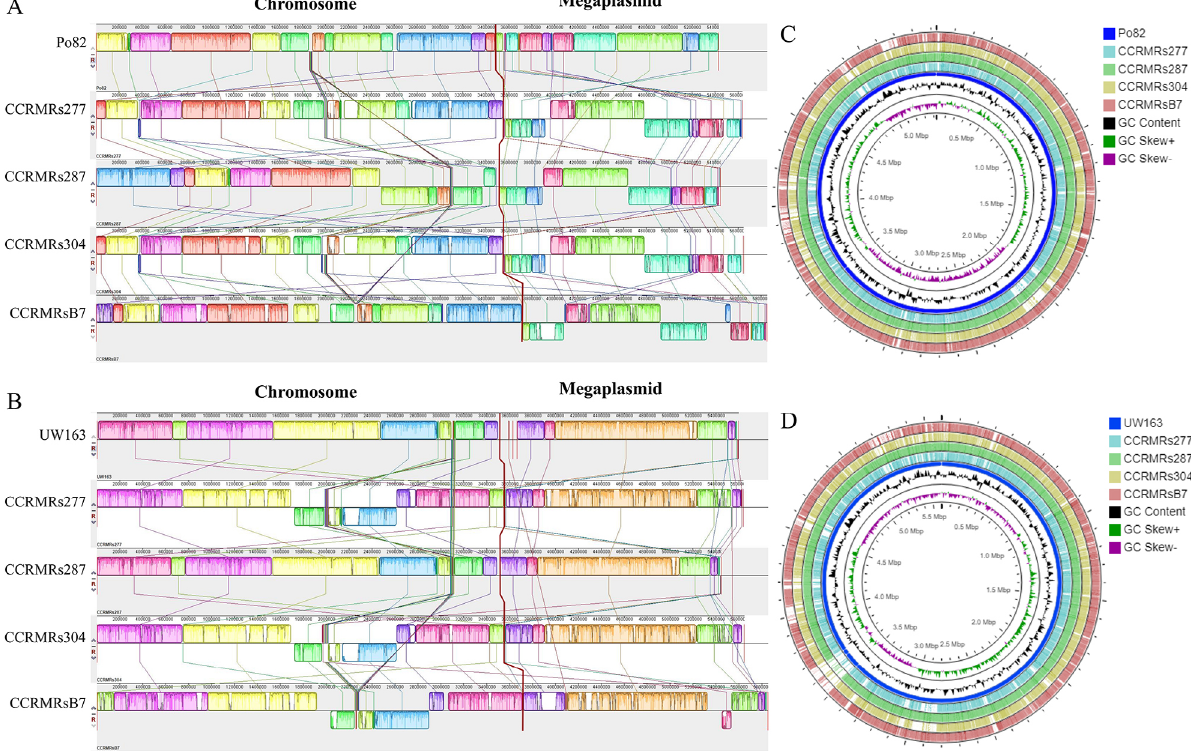
Figure 2 - Synteny of four R. solanacearum strains belonging to the Moko ecotype (CCRMRs277, sequevar IIA-24; CCRMRs287, sequevar IIB-4; CCRMRs304, sequevar IIA-24; and CCRMRsB7, sequevar IIB-25) from Brazil and reference strains Po82 (A) and UW163 (B). Visualization of the chromosome and megaplasmid alignments of the R. solanacearum strains and reference strains Po82 (C) and UW163